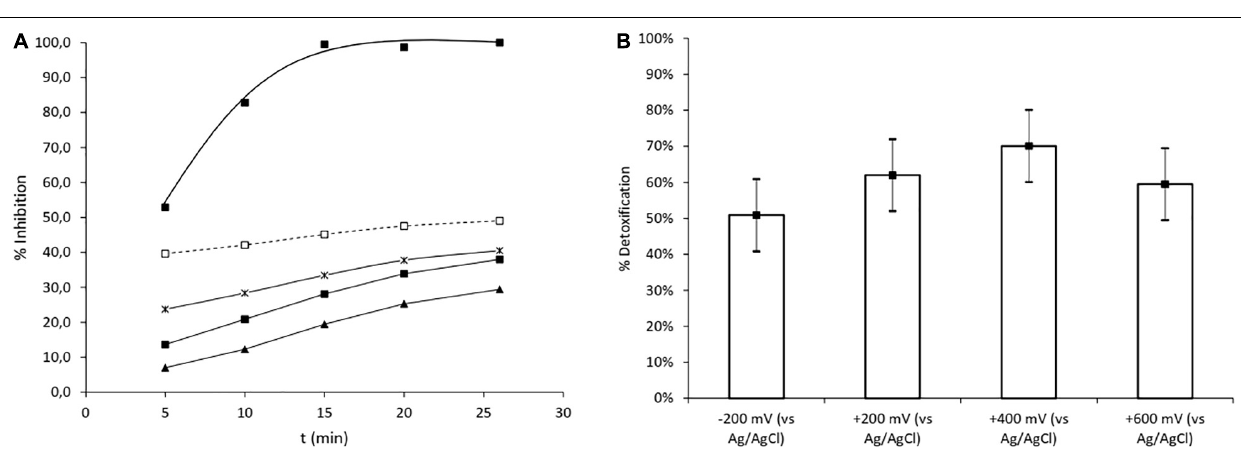
FIGURE 6 | Ecotoxicity test using V. fischeri . (A) Profile of bioluminescence inhibition during exposure time. (B) Detoxification of synthetic wastewater under different anode potentials. Symbols: (cid:4) % inhibition of non-treated synthetic wastewater, (cid:3) treated wastewater at − 200 mV (vs. Ag/AgCl), (cid:78) treated wastewater at + 400 mV (vs. Ag/AgCl), × treated wastewater at + 600 mV (vs. Ag/AgCl), (cid:4) treated wastewater at + 200 mV (vs.